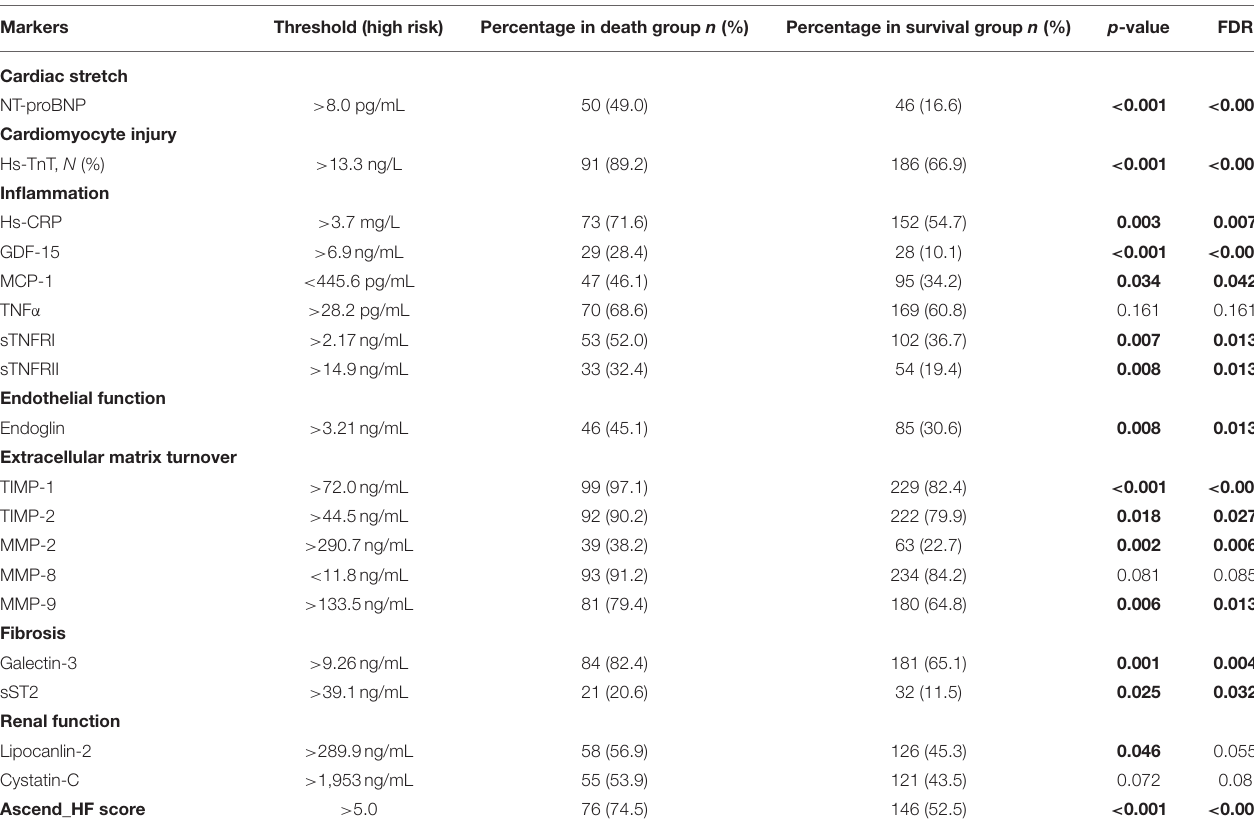
TABLE 2 | Percentage of high-risk patients by individual markers at baseline in the total population, death, and survival groups.